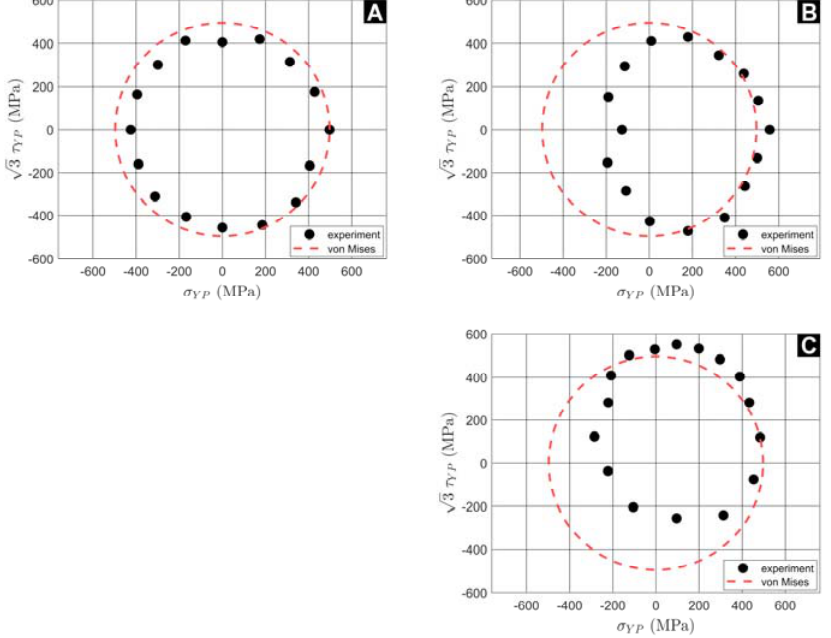
Figure 6. Initial YS of S235JR steel ( A ), subsequent YS after 1% axial prestrain ( B ), and subsequent YS after further 1% shear prestrain ( C ).